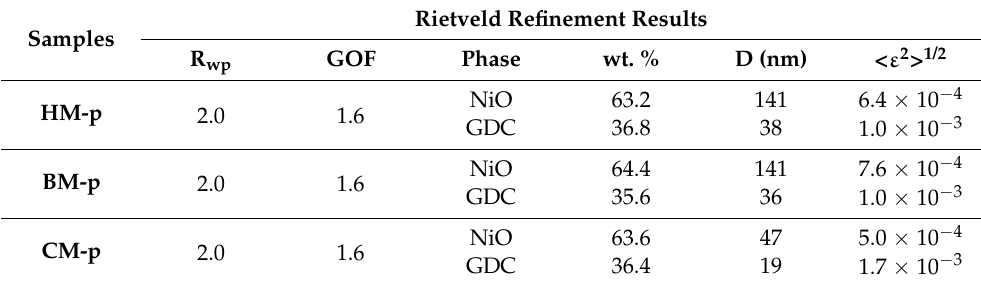
Table 2. Quantitative phase analysis of the nanocomposite performed by Rietveld refinement. The quality refinement parameters; GOF: goodness of fit; D: mean crystallite size and < ε 2 > 1/2 : root mean square (r.m.s.) of the microstrain are also presented. Rietveld Refinement Samples